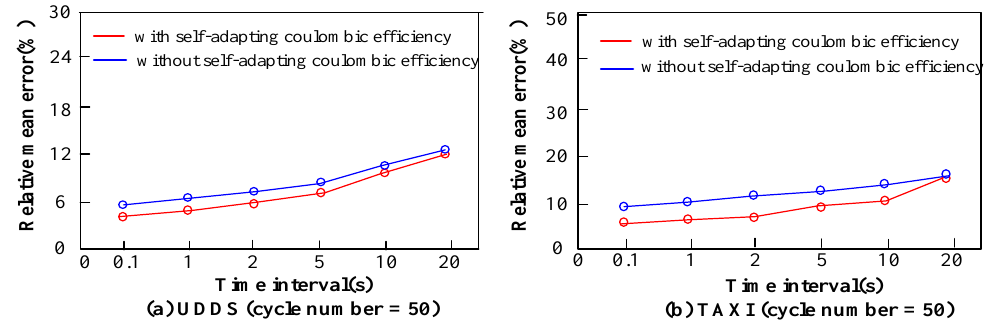
Figure 9. Relative mean errors of two different Coulomb counting methods. ( a ) UDDS; ( b )